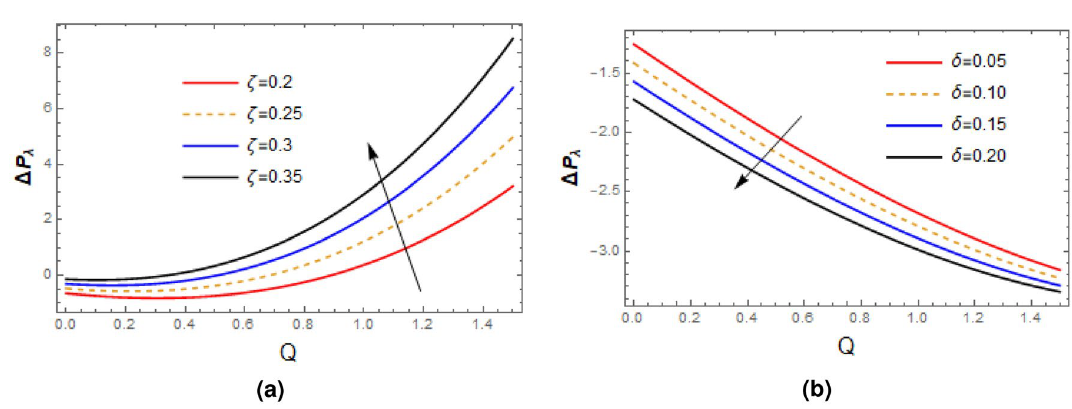
Figure 10. Plots of pressure rise per wave length, variations of ζ and δ are exhibited with α = 1, ε = 0.2, Q = 0.5 ( a ) δ = 0.05 , ( b ) ζ = 0.02 .